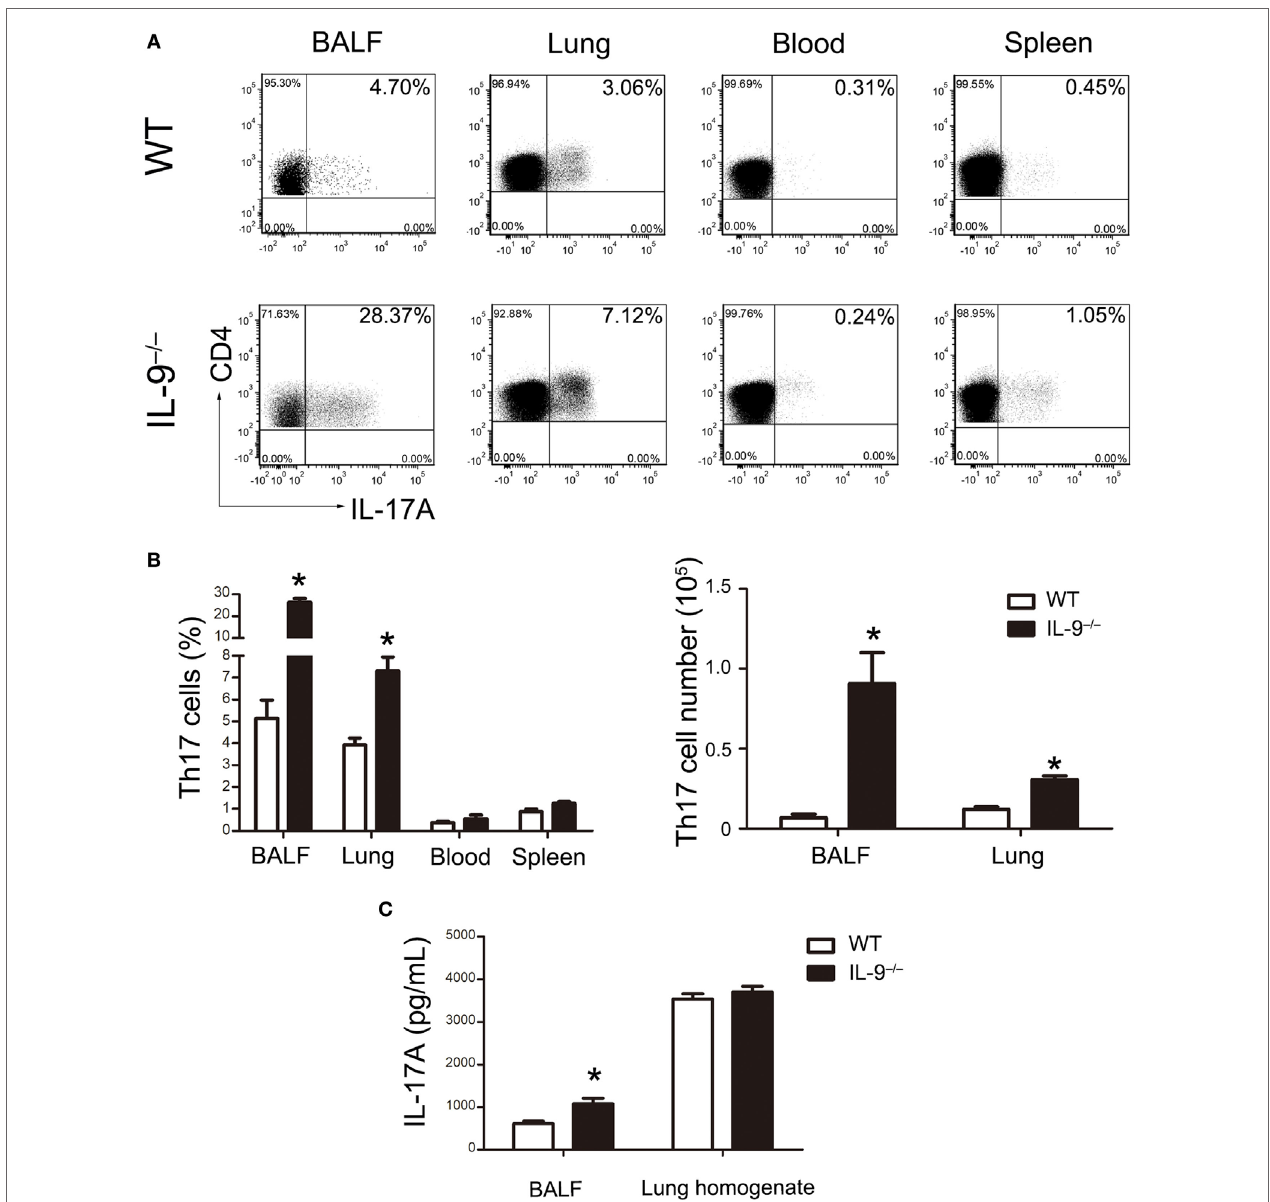
FigUre 2 | IL-9 deficiency promoted Th17 responses during Pneumocystis infection. (a) Cells were isolated from bronchoalveolar lavage fluid (BALF), lung, spleen, and blood and then stimulated as described previously. The representative flow cytometric dot plots of Th17 cells (CD4 + IL-17A + , gated on cells from CD3 + CD4 + lymphocytes) from WT mice (top panel) and IL-9 ‒ / ‒ mice (bottom panel) 3-week post- Pneumocystis infection. (B) The comparisons of Th17 percentage (left) and absolute number (right) were shown from different tissues in WT and IL-9 ‒ / ‒ PCP mice. Data were presented as mean ± SEM from three to five mice per group. (c) The IL-17A levels were determined in BALF and lung homogenate supernatants by ELISA from WT and IL-9 ‒ / ‒ PCP mice at 3-week postinfection. The IL-17A concentrations were expressed as mean ± SEM from four to five mice per group. The results were from three independent experiments. * P < 0.05 compared to WT group by Student’s t